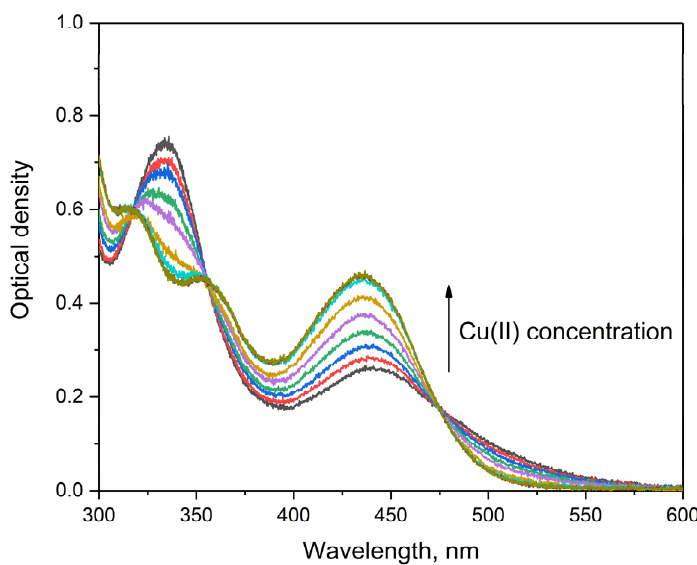
Figure 2. UV-Vis absorption spectra of 0.06 mM Q1 solutions containing CuCl 2 in the concentration range 0–0.04 mM in ethanol at 25 °C.